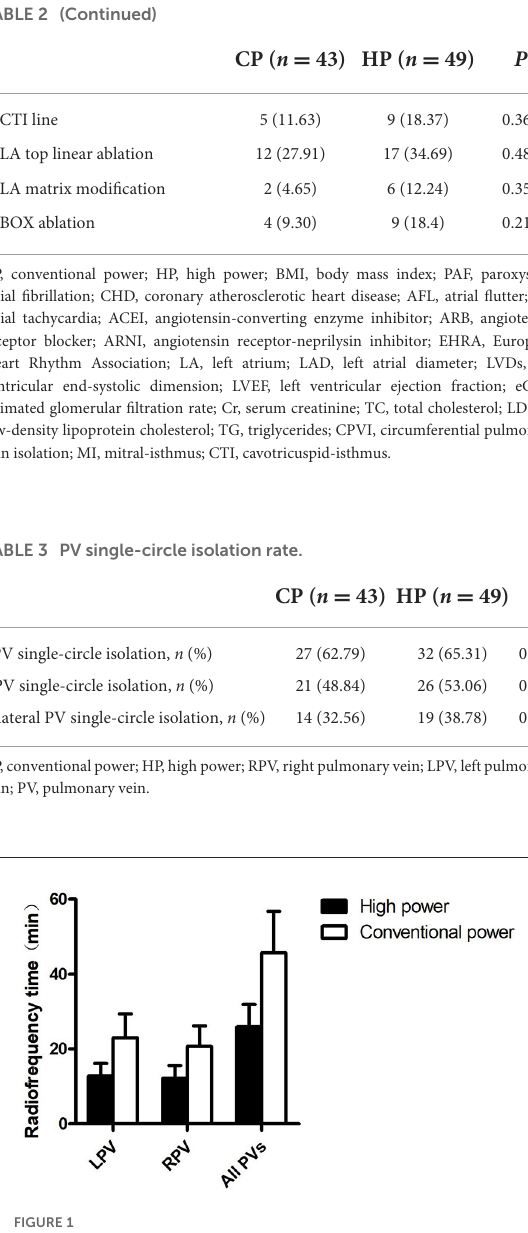
FIGURE1 Ablation time. LPV, left pulmonary vein; RPV, right pulmonary vein; PV, pulmonary vein.